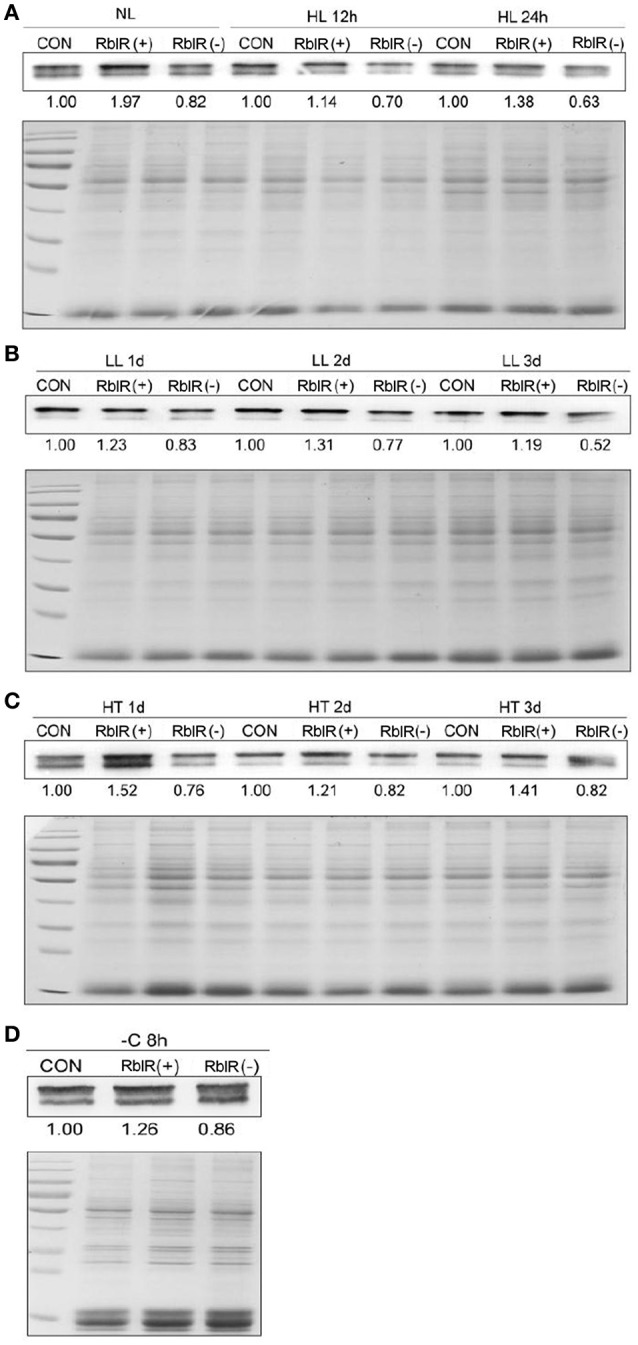
Analysis of RbcL from RblR mutant strains. Immunoblot analysis of RbcL protein in the control and RblR (+)/(−) mutant strains under NL (A, OD730 = 0.6), HL (A, 300 μE 12, 24 h), LL (B, 2 μE 1, 2, 3 days), HT (C, 42°C 1, 2, 3 days), and -C (D, carbon-free BG11, 8 h) conditions. The bottom panel is 20 μg total protein served as a loading control. Coomassie-stained sections of the polyacrylamide gel are shown. All data are shown as the means ±SD (n = 5).